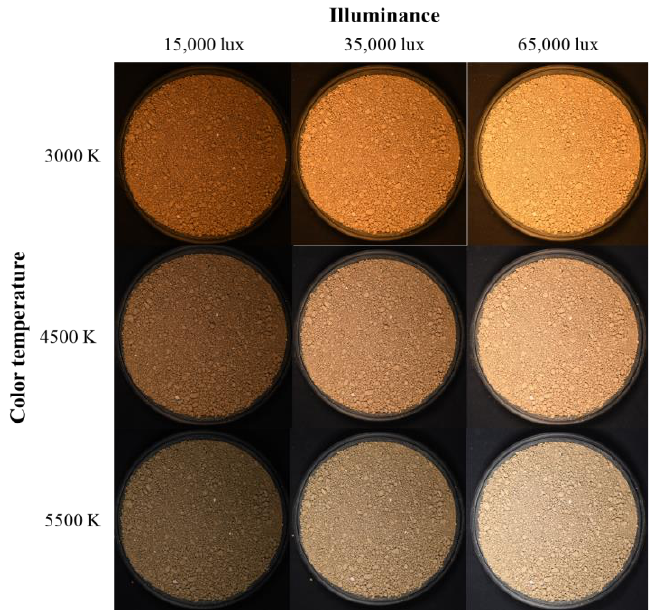
Figure 5. Digital images of Yongin soil.